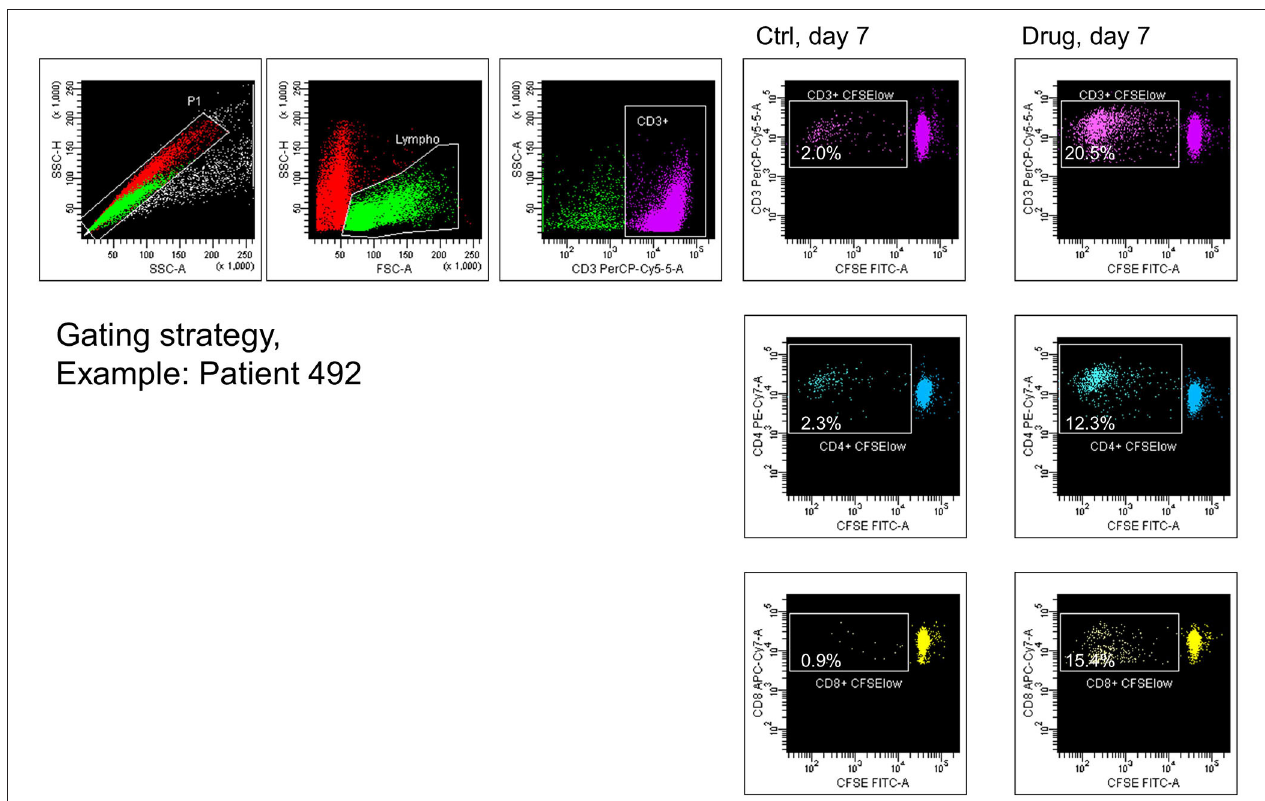
FIGURE 1 | Proliferation, gating, sorting, and cloning of drug-reacting T cells. Peripheral blood mononuclear cells (PBMCs) from the patients of β -lactam hypersensitive (here, the example of patient 492) were labeled with 5,6-carboxyfluorescein succinimidyl ester (CFSE) and cultured in the absence (ctrl) or in the presence of the culprit β -lactam (drug). After 7 days, cell cultures were stained with anti-CD3, anti-CD4, and anti-CD8. Events were gated on singlet cells and lymphocytes, such as larger and more granular effector lymphocytes. CD3 + T cells showing low intensity of CFSE were sorted and directly cloned by limiting dilution. Percentages of CFSE low in the CD3, CD4, and CD8T cell compartment were determined.